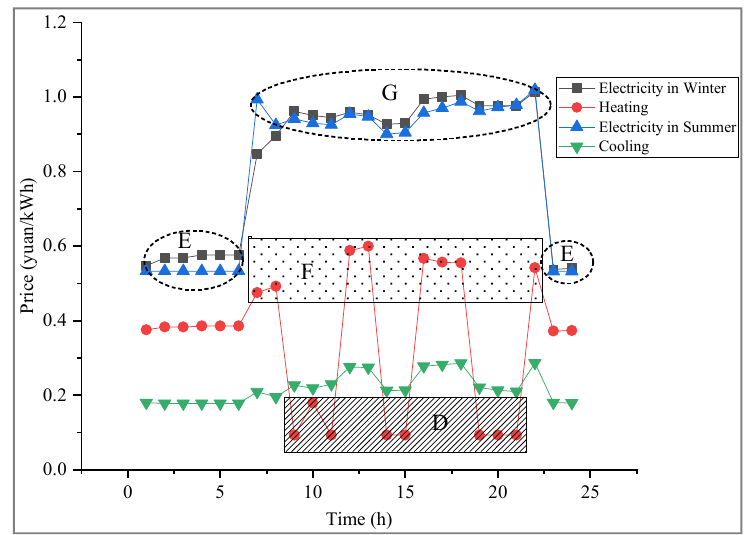
Figure 6. Cost of cooling, heating, and electricity when the ratio of the shifted load to the total peak load (TR) = 0.